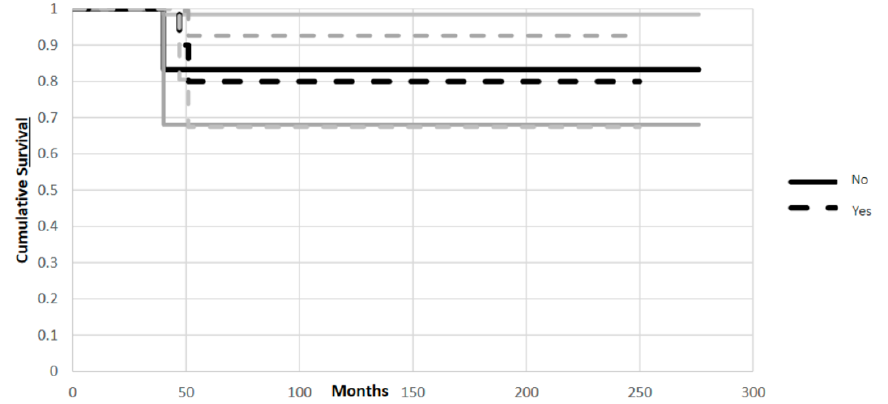
Figure 4. Kaplan-Meier plot shows similar survival rate in Group 1 with ligament in the reconstruction (Yes) or without artificial ligament in the reconstruction (No), at 120 months (CI 95%, p = 0.02). The endpoint of analysis was at least one surgical operation for revision of implant due to mechanical failure (aseptic loosening, fracture or resorption of the allograft, dislocation or breakage of the hardware). Grey lines represent standard deviation.